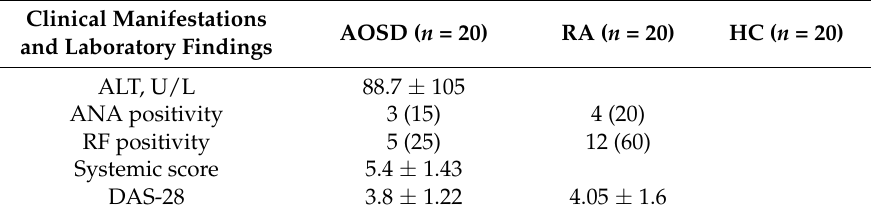
Table 2. Clinical characteristics of patients.